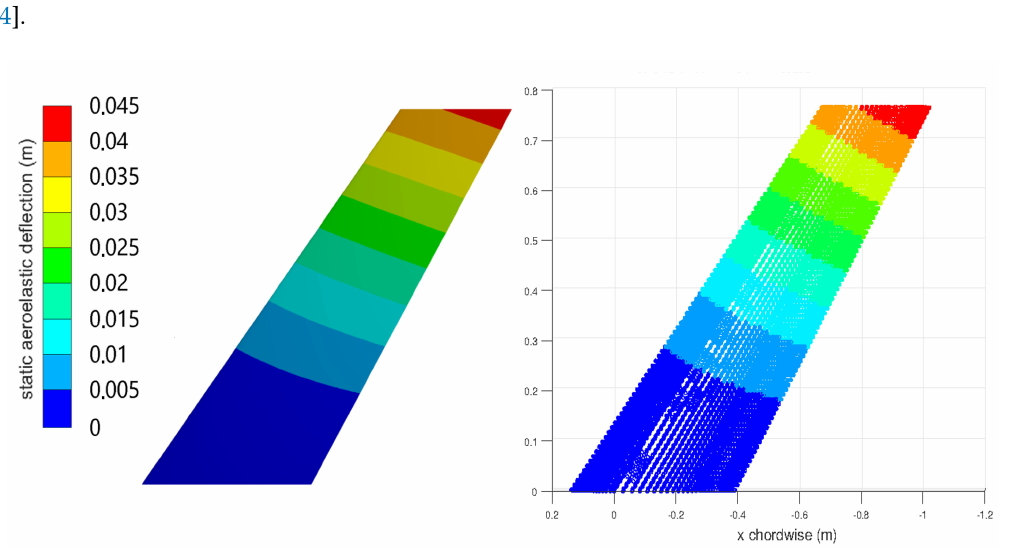
Figure 10. AGARD wing Case l: static aeroelastic displacement, full solution ( left ) and ROM ( right